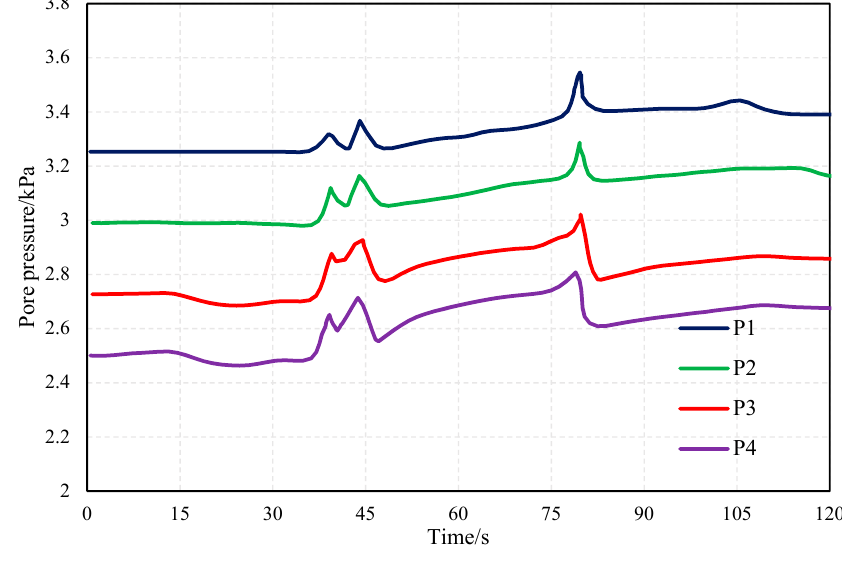
Figure 21. Measured pore pressure in Model 8-10.